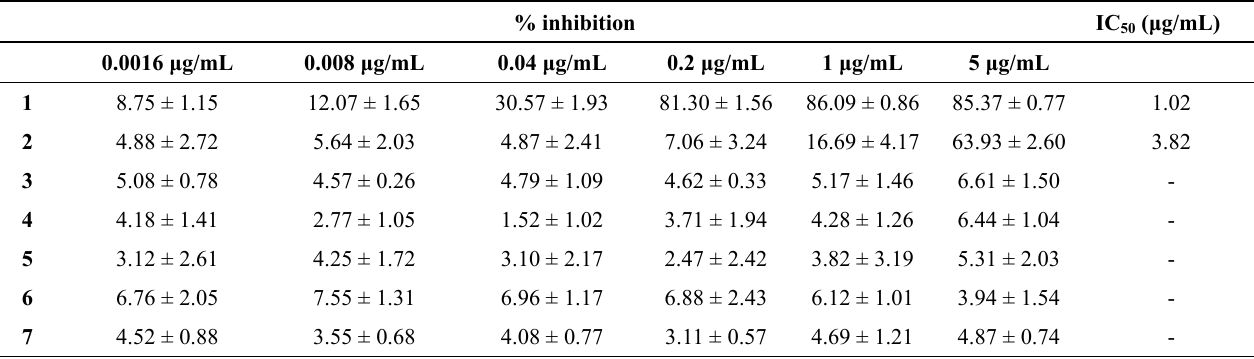
Table 1. The effects of components on DPPH